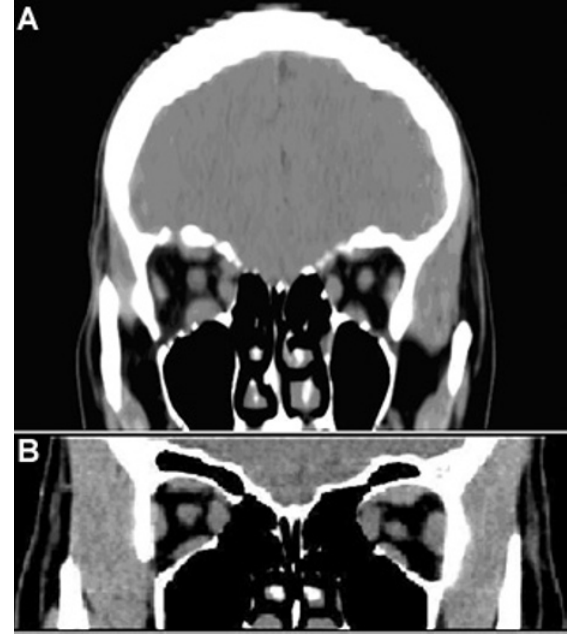
Figure 1. Coronal CT images from case 1 showing (A) enlargement of the belly of both medial and inferior recta, of right superior rectus and superior oblique. Case 2 CT images (B) showed enlargement of left superior, both medial and lateral